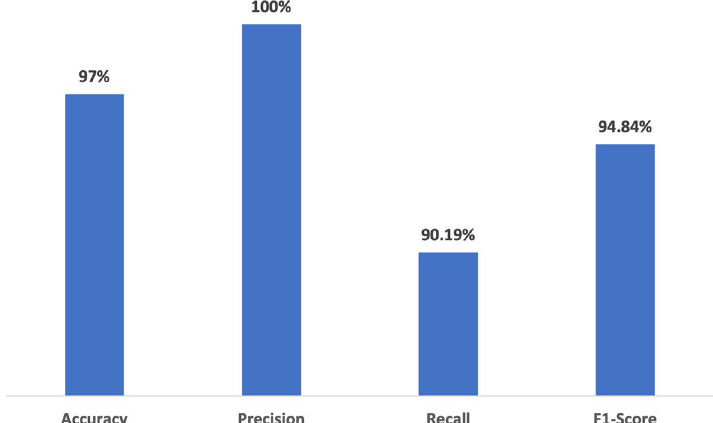
Fig. 7 Our proposed method’s results for detecting replay